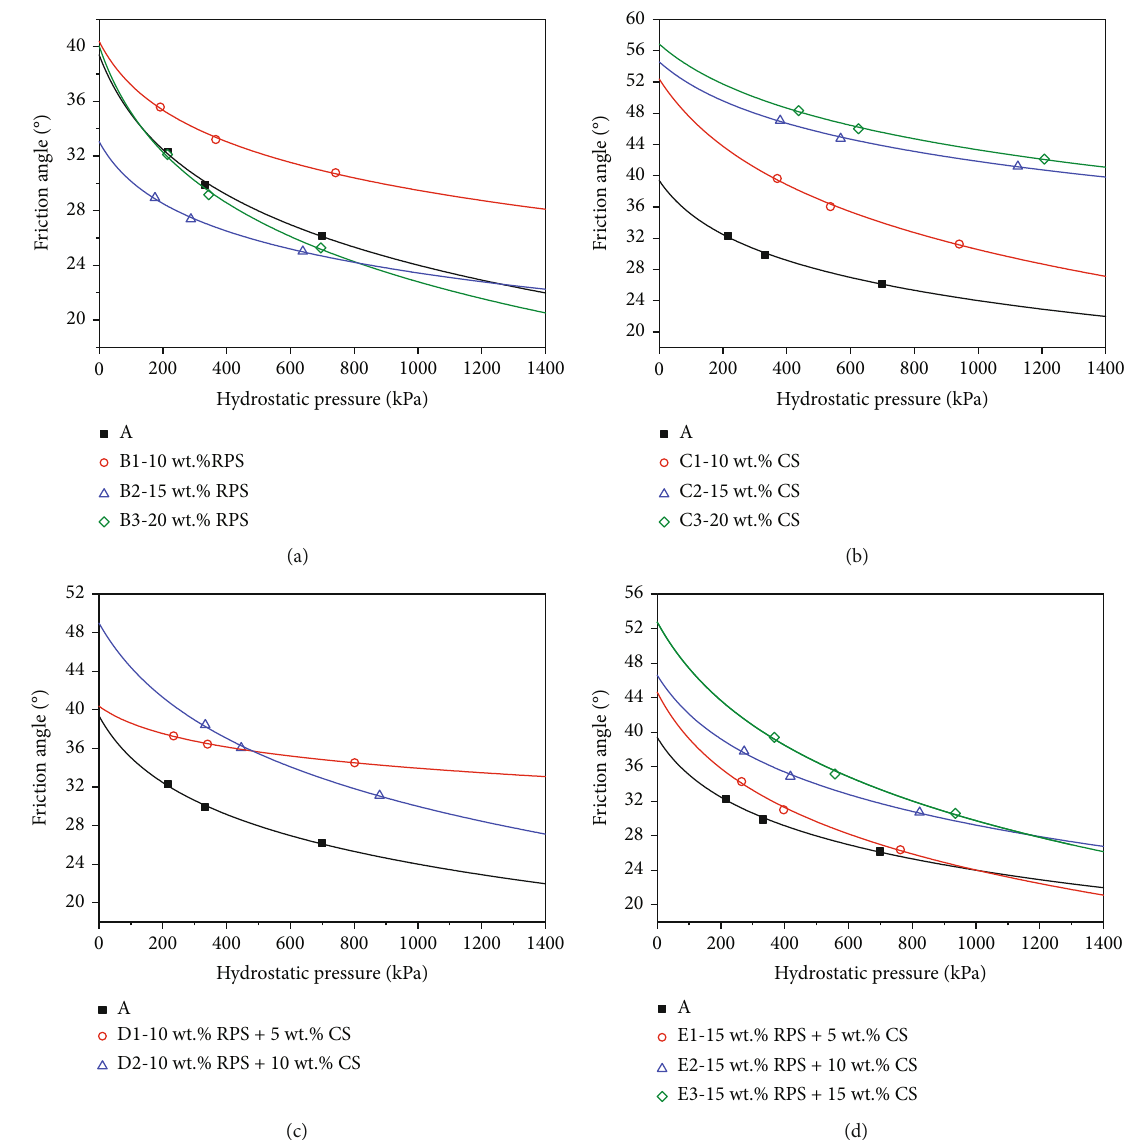
Figure 8: Relationships between the hydrostatic pressure and the friction angle for the modi fi ed soils: (a) the red Pisha sandstone modi fi ed soils; (b) the carbide slag modi fi ed soils; and (c, d) the red Pisha sandstone and carbide slag modi fi ed